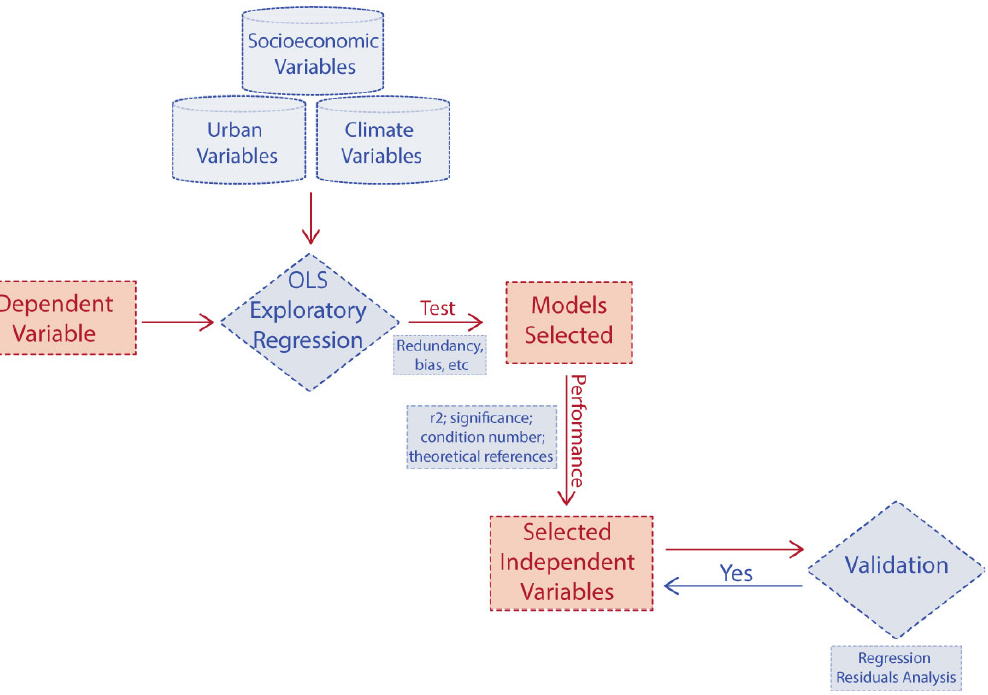
Figure 1. Data flow diagram of the proposed spatial regression model.